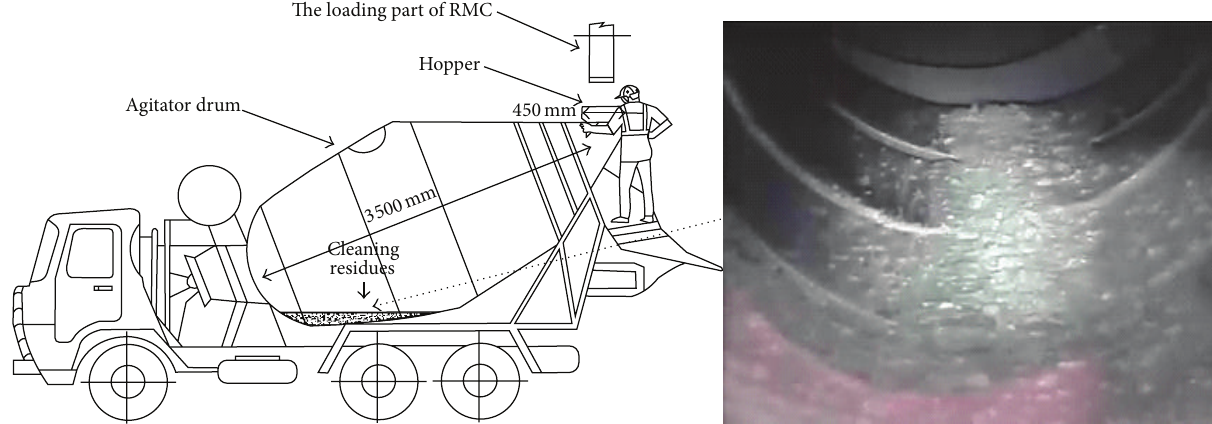
Figure 2: The shape of RMC truck and cleaning residues in the agitator drum.